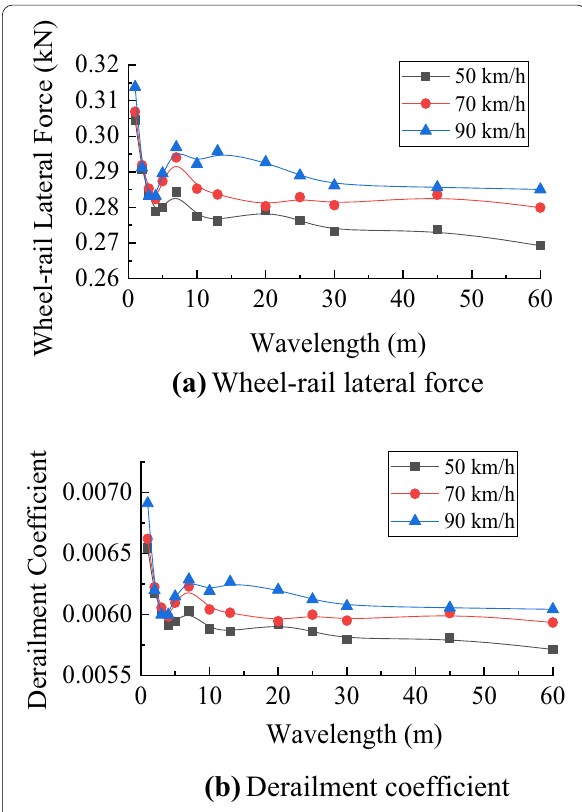
(a) Wheel-rail lateral force